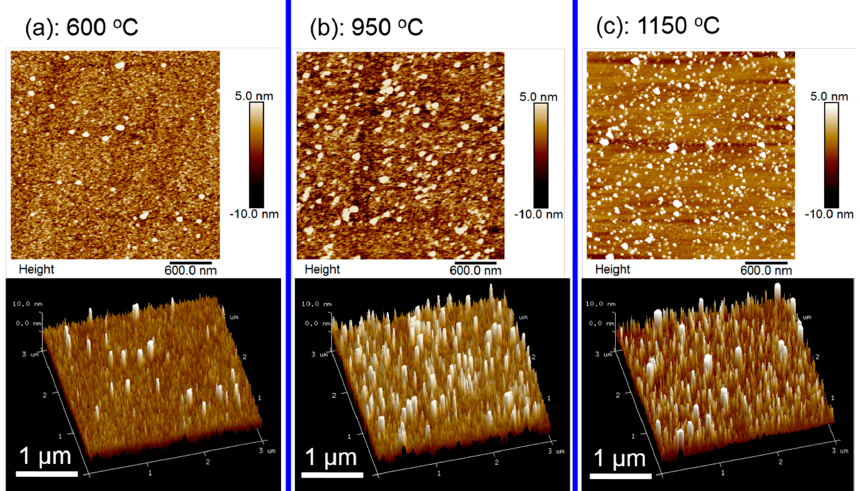
Figure 6. AFM images of AlN buffers grown at temperatures of ( a ) 600 °C; ( b ) 950 °C; and ( c ) 1150 °C, respectively, with a scanning area of 3 × 3 μ m 2 . Upper and lower arrays show the two-dimensional and three-dimensional images, respectively.